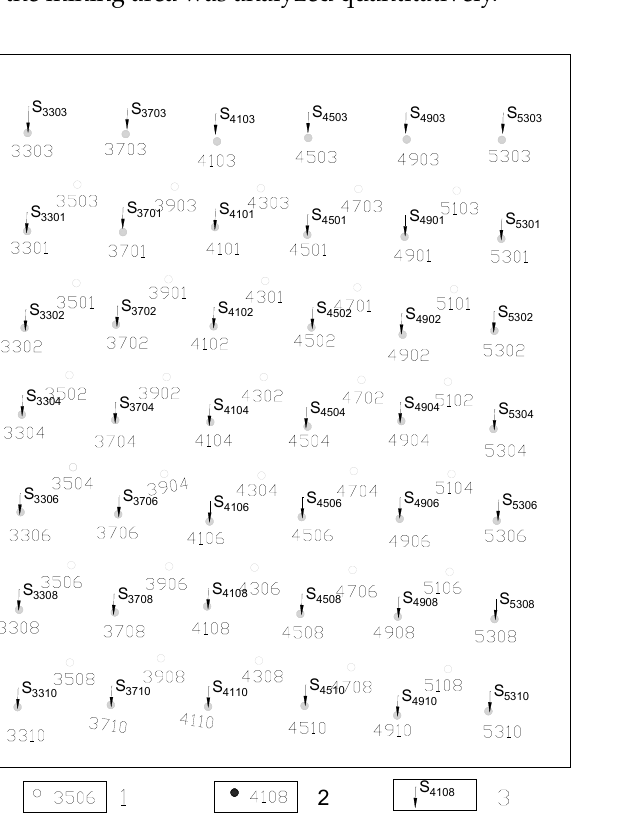
Figure 9. Schematic diagram of neutral solute number and corresponding injection well in the model.